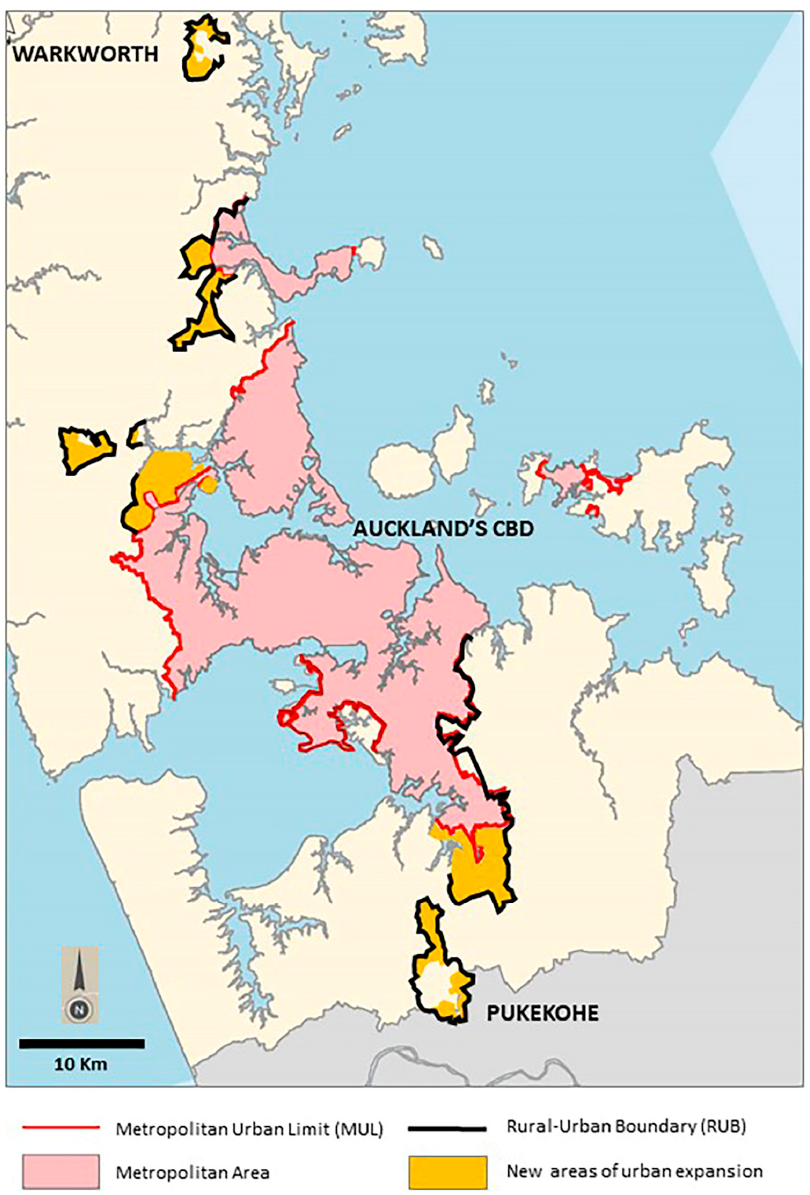
Figure 7. Map of the metropolitan area of Auckland showing the MUL, the RUB and areas of expansion (Author’s map).